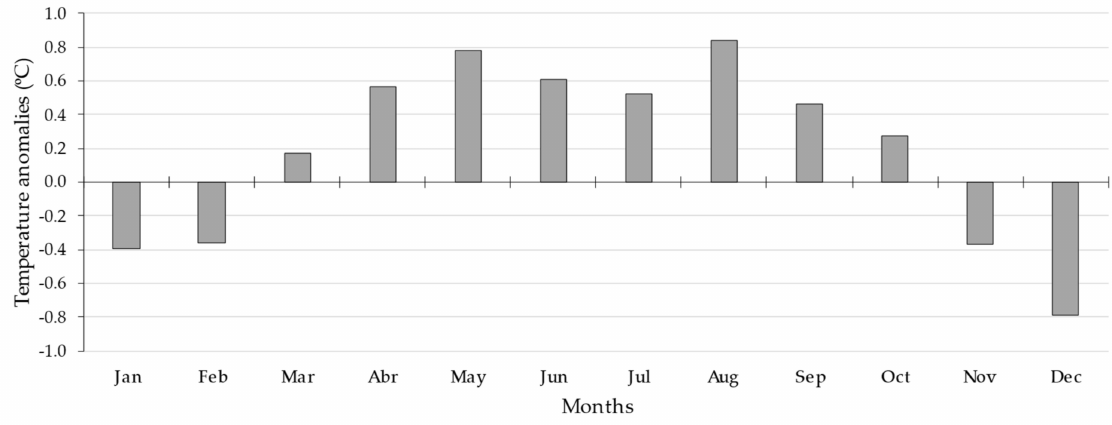
Figure 12. Distribution of monthly mean values for temperature anomalies in the period of